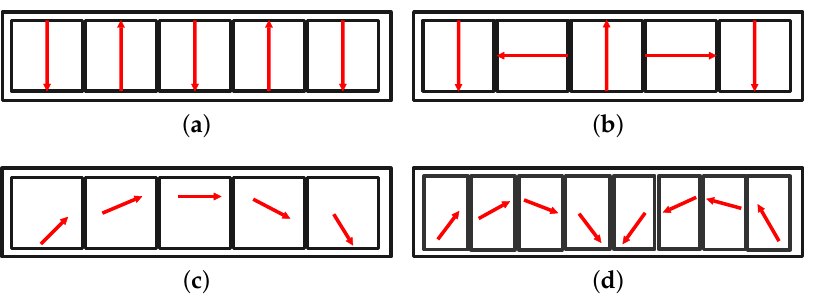
Figure 8. Permanent magnetic chuck magnetization method. ( a ) Opposite magnetization. ( b ) Halbach magnetization. ( c ) Sinusoidal magnetization. ( d ) PMAD magnetization.